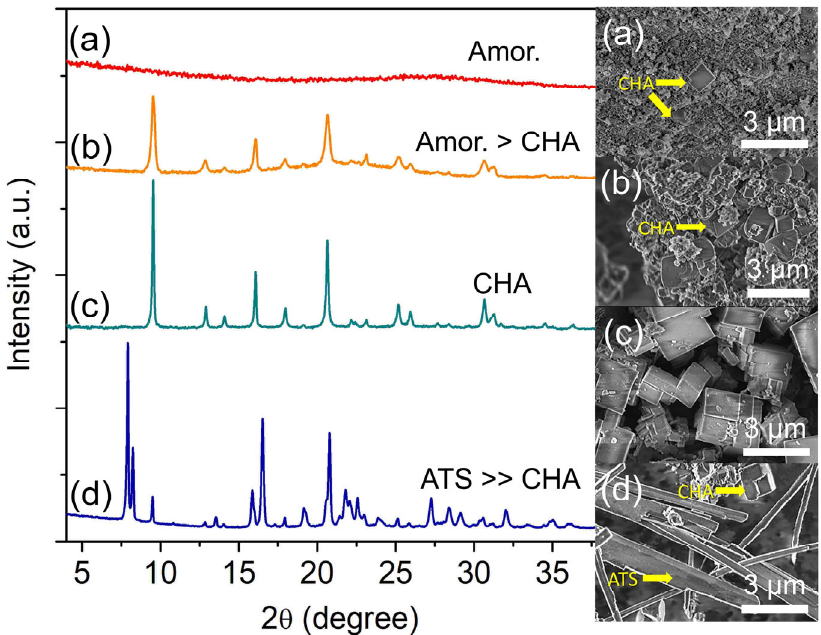
Figure 6. XRD patterns and FESEM micrographs of ( a ) S ‐ 17, ( b ) S ‐ 18, ( c ) S ‐ 3, and ( d ) S ‐ 19